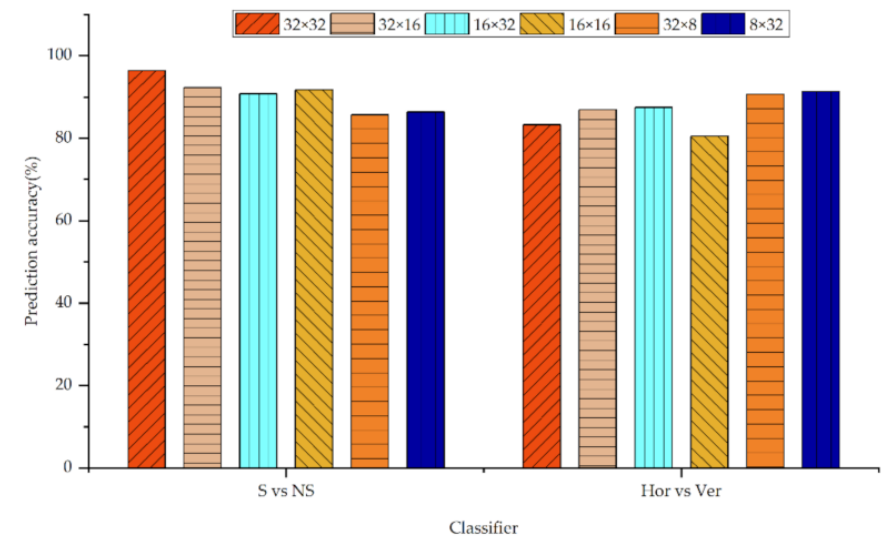
Figure 8. The prediction accuracy of the proposed SVM